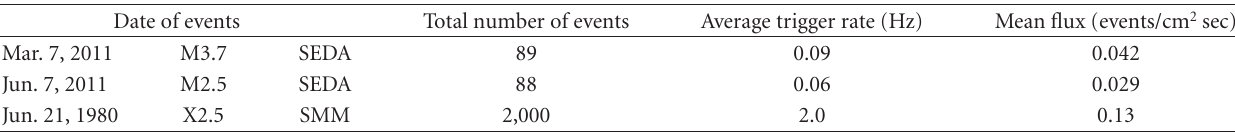
Table 3: Acomparison of solar neutron events observed by the SEDA-FIB detector with SMM event. The average trigger rate is simply obtained by dividing the total number of events by the observation time, while the mean flux is obtained taking the detection e ffi ciency of both detectors into account (0.021 and 0.3 for SEDA and SMM) and also the detector area (100 and 450 cm 2 for SEDA and SMM).